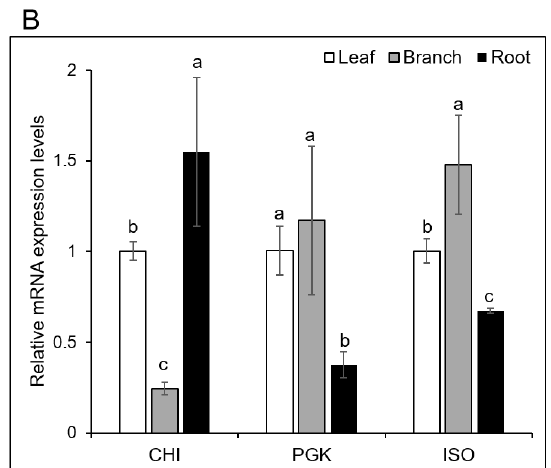
Figure 7. Total flavonoid contents and the expression of three genes in the three organs from Morus . The total flavonoids extracted from Morus leaf, branch, and root were analyzed using a colorimetric method ( A ). The transcript abundance of the selected genes was analyzed by qRT-PCR. Total RNA was extracted from the collected leaf, branch, and root ( B ). Data are shown as the means ± SD from three independent biological replicates. Means with the same letter are not significantly different according to one-way ANOVA test ( p < 0.05). The abbreviations are follows: QE, quercetin-3-O-rutinoside. The genes CHI, PGK, and ISO represent chalcone flavanone isomerase, phosphoglycerate kinase, and isoflavone reductase, respectively. The β -actin gene was used as a reference control gene.